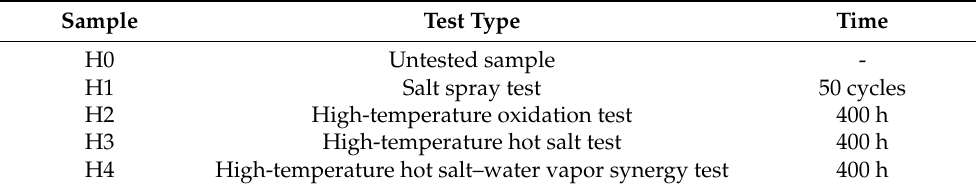
Table 2. Details of the test design for Ti6Al4V alloy.